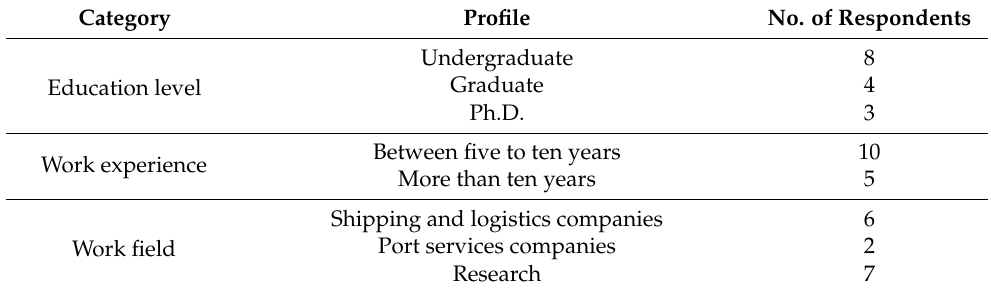
Table 6. Experts’